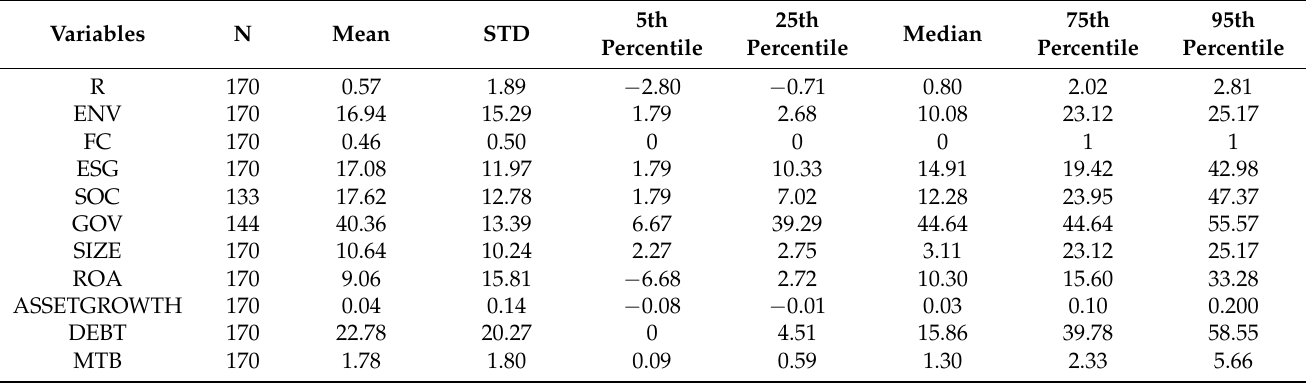
Table 2. Descriptive